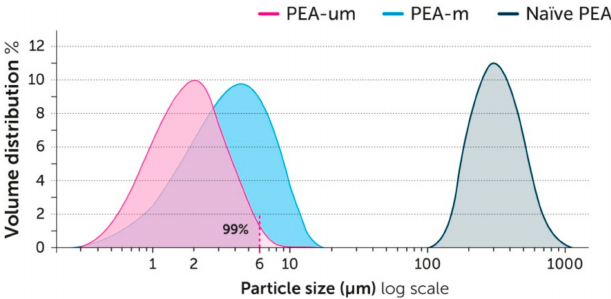
Figure 5. Particle size distribution profile of di ff erent PEA formulations. More than 99% and about 60% by weight of PEA-um has a particle size lower than 6 and 2 µ m, respectively.